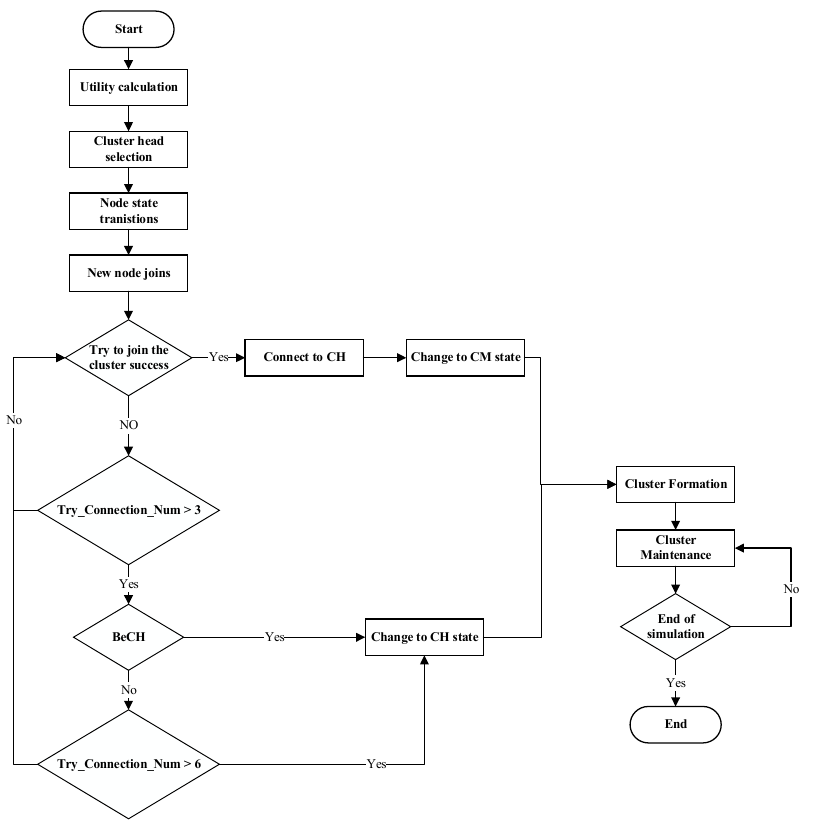
Figure 4. BPCA scheme flowchart. Table 2. Period of repeated tasks in the simulation.